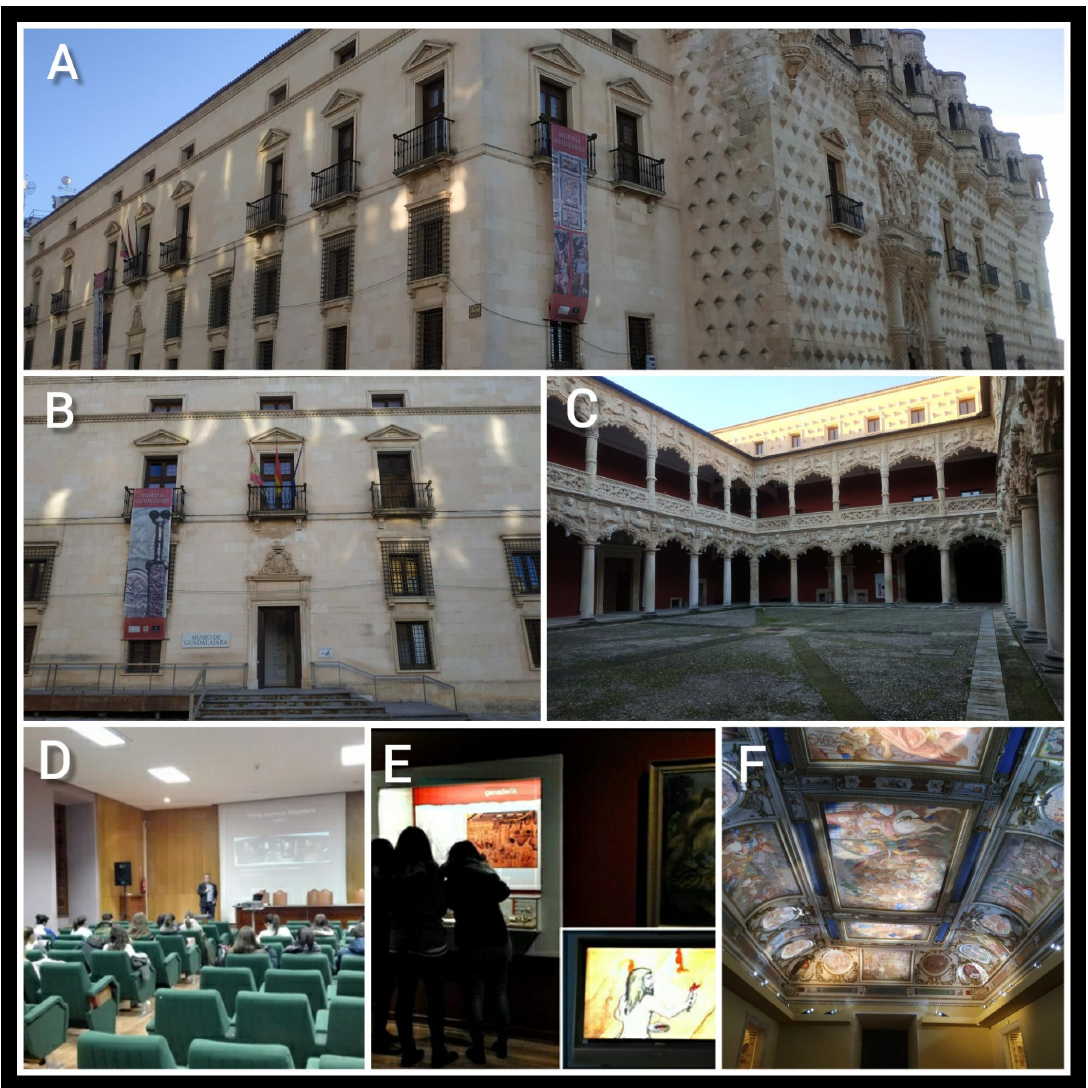
Figure 4. Museum of Guadalajara. ( A ): Facade of the Infantado Palace. ( B ): Access door. ( C ): Courtyard of the Lions. ( D ): Talk about museography. ( E ): “Transits” room (lower right frame: Video, in another room, on the cave paintings). ( F ): Room of “El Palacio del Infantado: Mendoza and power in Castilla”.